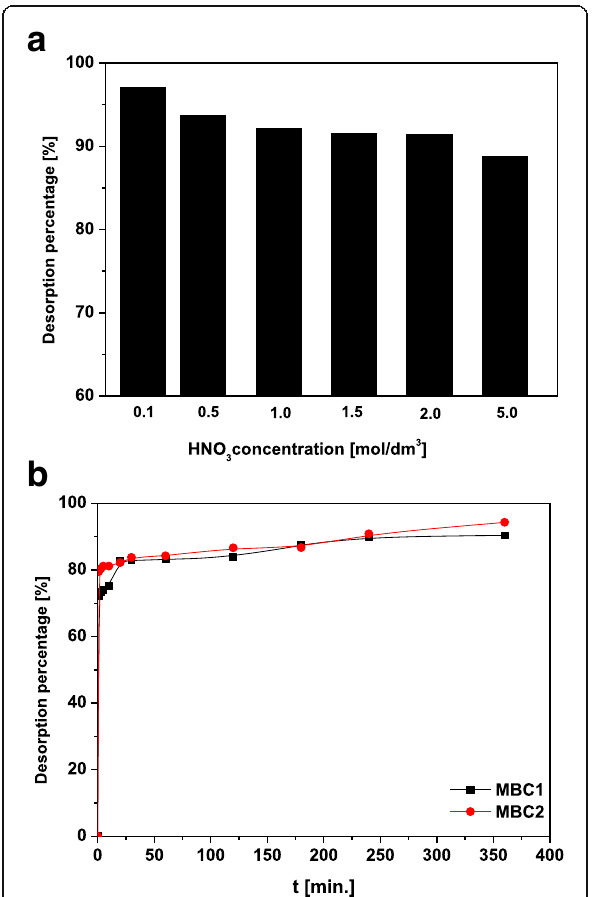
Fig. 4 a Elution of Cd(II) from metal-loaded MBC2 using HNO 3 at the concentrations in the range 0 – 2 mol/dm 3 and b effect of the phase contact time on Cd(II) desorption on metal-loaded MBC1 and MBC2 using 0.1 mol/dm 3 HNO